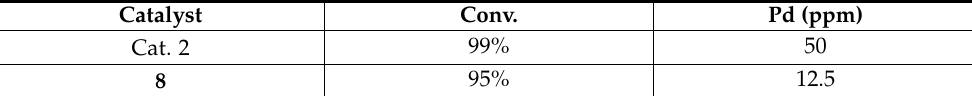
Table 2. Comparative leaching measurement of Cat. 2 and compound 8 . Catalyst Conv. Pd (ppm) Cat.